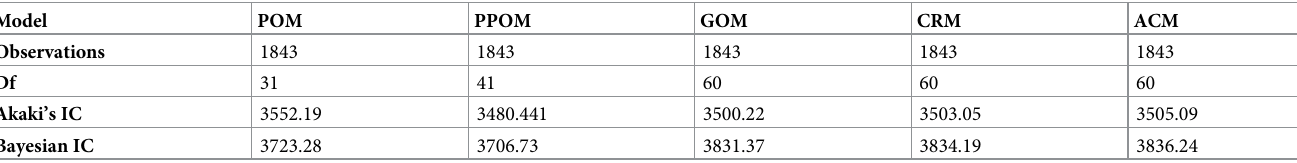
Table 3. AIC and BIC values for all ordinal